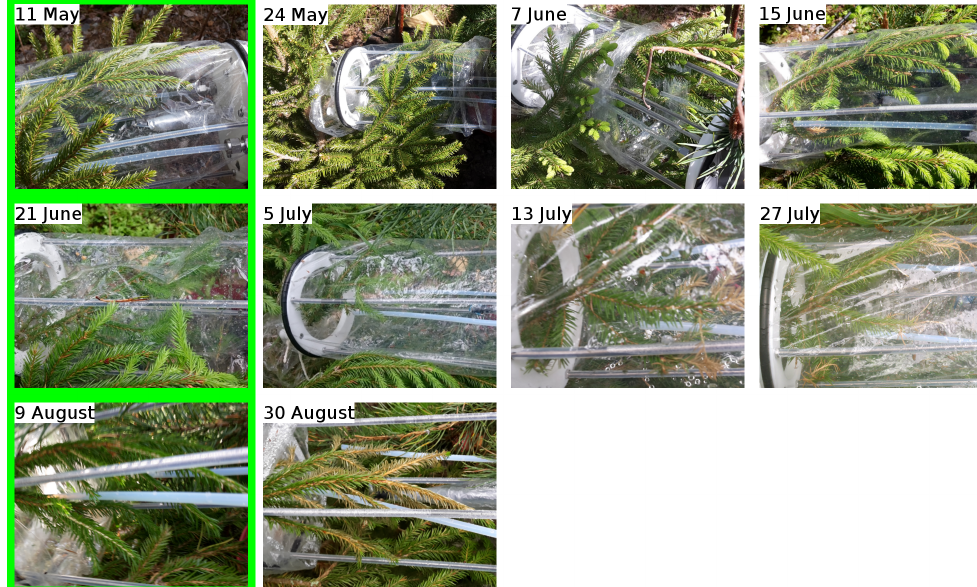
Figure A2. Pictures of spruce branches. Dates framed in green indicate that a new branch was placed in the enclosure.